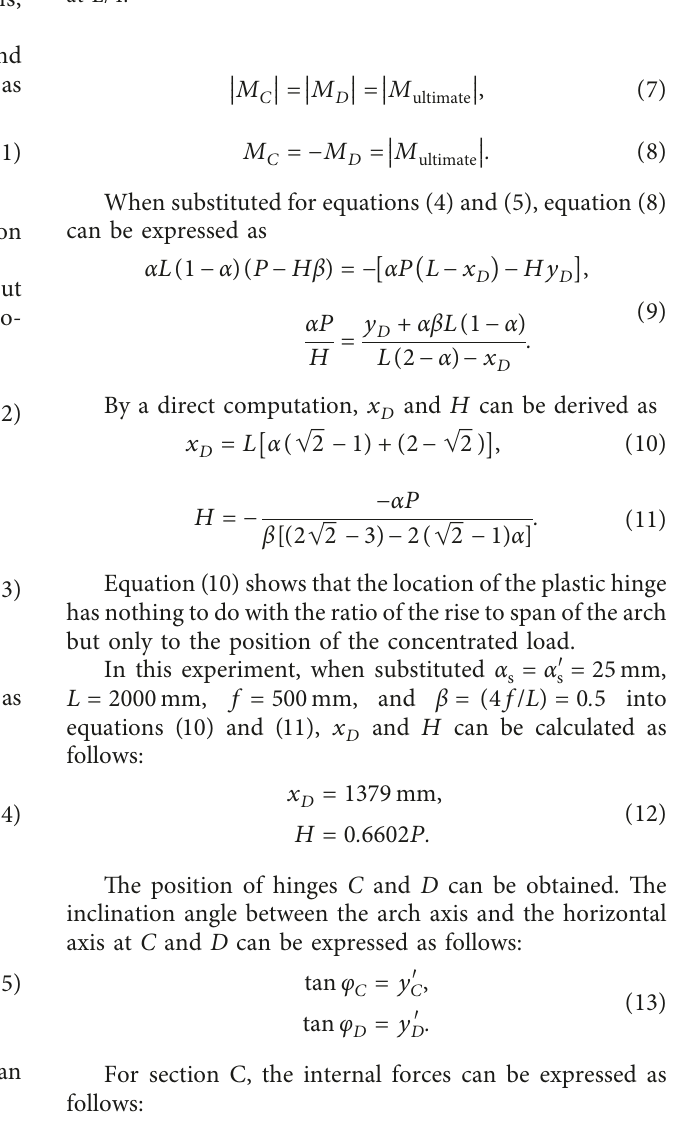
Figure 10: Failure mode of the arch under a concentrated load at